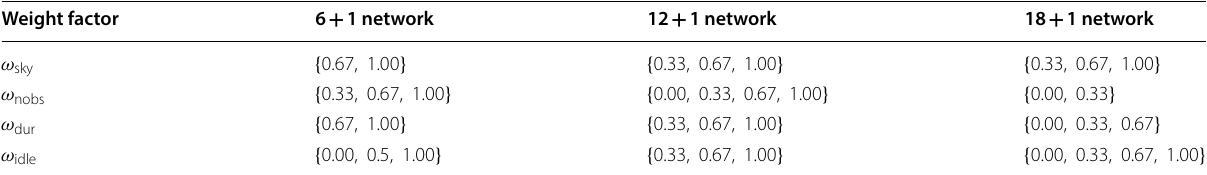
Table 2 Table of weight factors identified from training runs (and earlier investigations of 6 in global runs